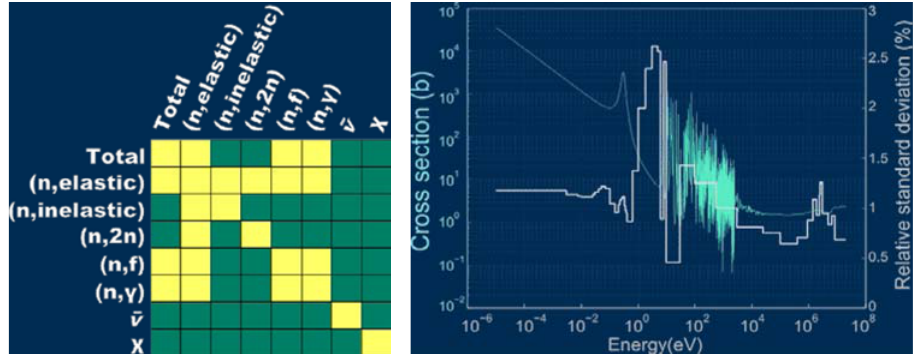
Figure 2. An illustration on the NUSS ND sampling approach (left – the total CM; right – a cross-section and its group-wise standard